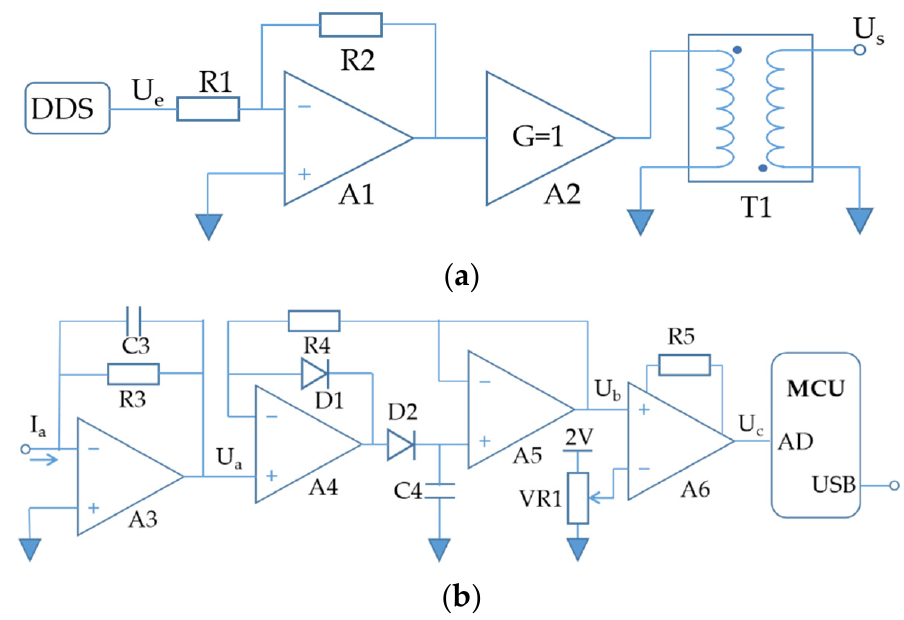
Figure 2. Schematic diagram of ( a ) excitation circuit and ( b ) receiving circuit.